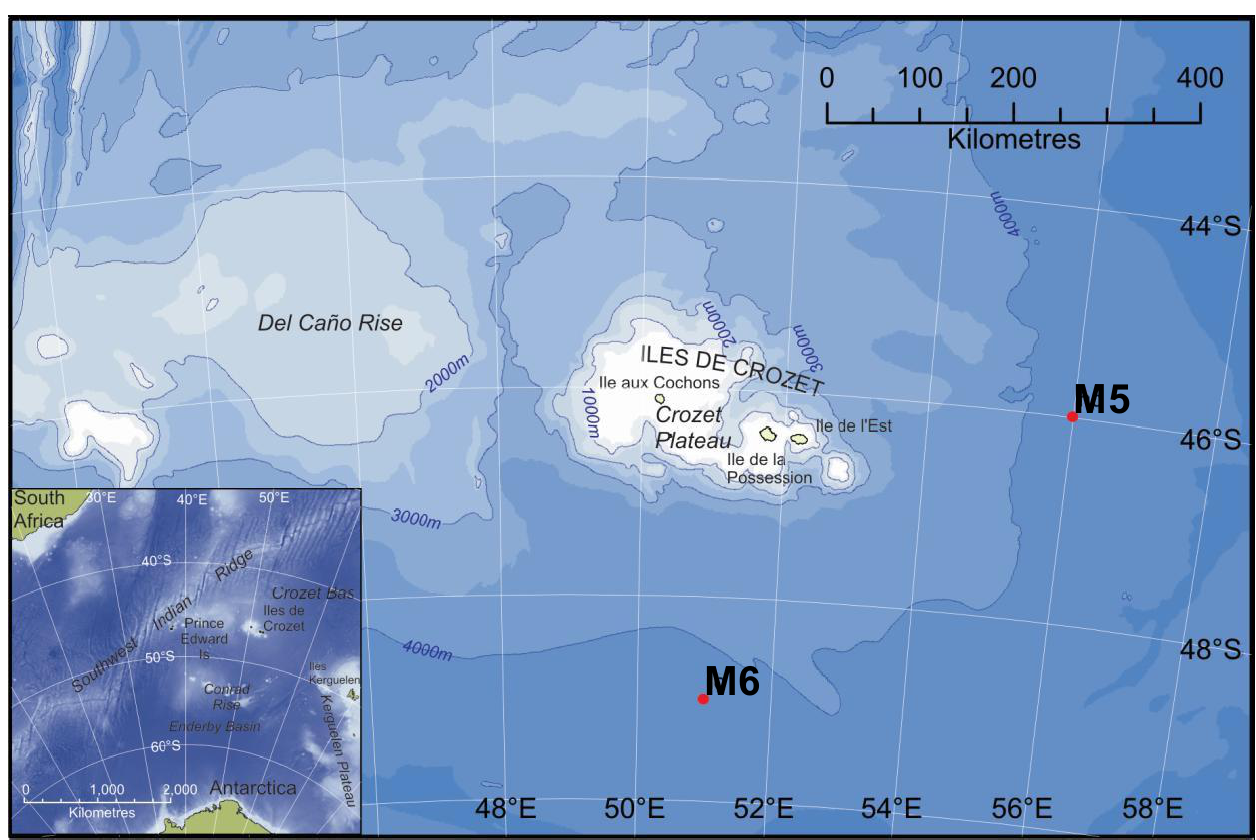
Figure 1. Map showing positions of sites M5 and M6 respectively in the vicinity of the Crozet islands. Inset shows the location of the Crozet Plateau east of the Southwest Indian